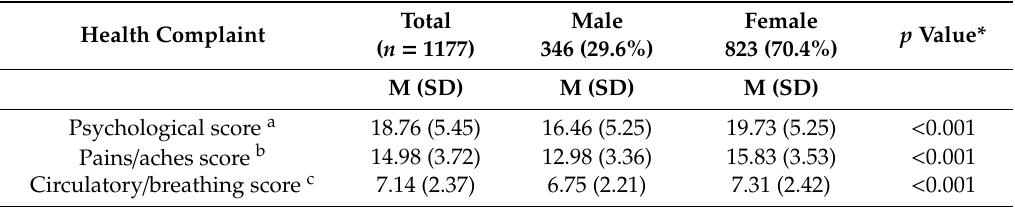
Table 4. Self-reported health complaints mean score (last 12 months) by gender among undergraduates, University of Turku,